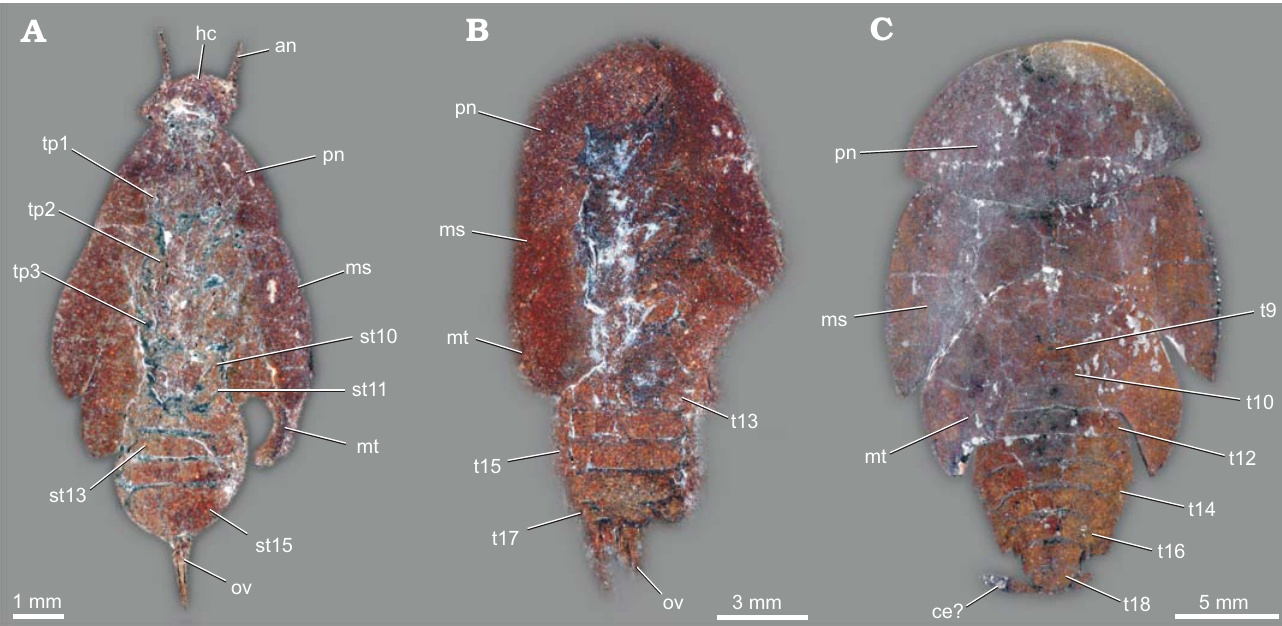
Fig. 8. Roachoid nymphs from the Carboniferous Carbondale Formation of Mazon Creek, USA; with interpretations of preserved structures. A . YPM 000057. B . YPM IP 027872. C . YPM IP 027870. Abbreviations: an, antenna; ce, cercus; hc, head capsule; ms, tergite of mesothorax; mt, tergite